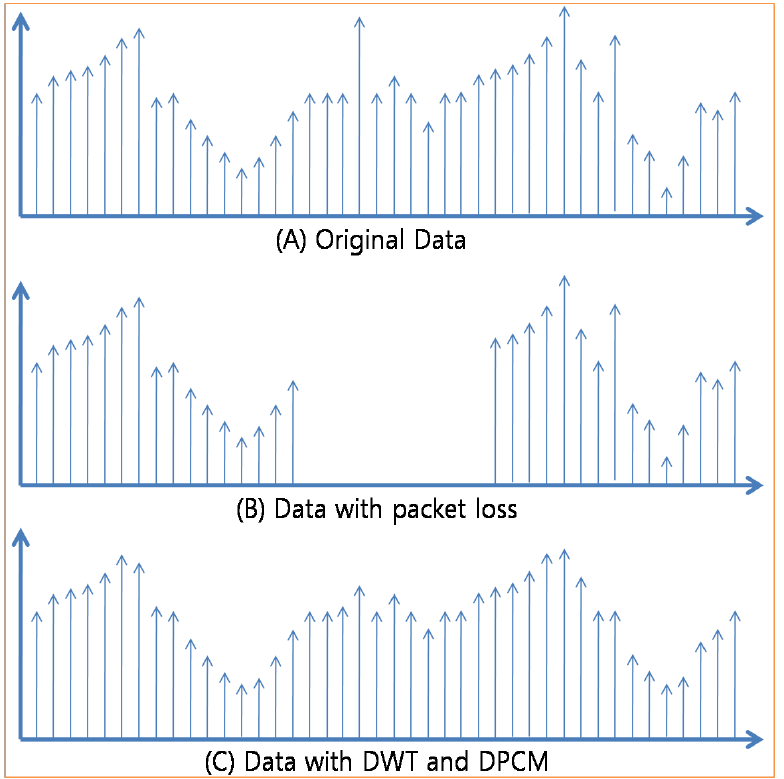
Figure 11. Packet loss and